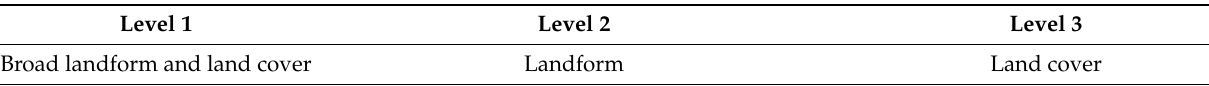
Table 1. The level 1–3 classification categories used for characterising the visual and sensory aspect areas in the Landscape Assessment Decision Making Process (LANDMAP) approach, adapted from [31]. The grey background is used to easily distinguish the descendants of each level-2